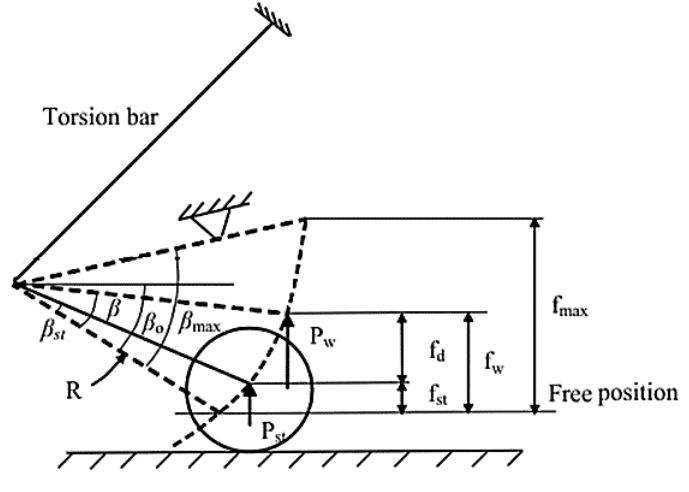
Figure 6. Individual torsion bar suspension [10,